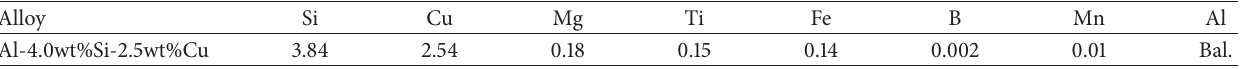
Table 2: Chemical composition of the Al-4.0wt%Si-2.5wt%Cu alloy [in wt%], obtained by optical emission spectrometry. Alloy